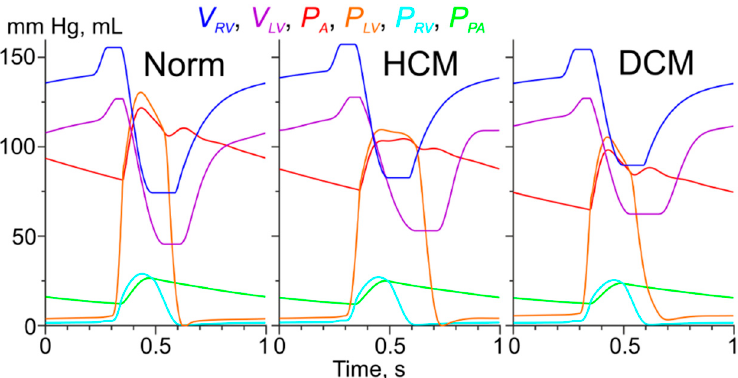
Figure 2. The results of the simulations of heartbeats for model of the normal (Norm) left ventricle (LV) cardiac muscle and those with the Ile284Val (hypertrophic cardiomyopathy, HCM) and Asp230Asn (dilated cardiomyopathy, DCM) Tpm mutations. V RV , V LV are volumes of the right and left ventricles, respectively; P A , P LV , P RV , and P PA are pressures in aorta, left and right ventricles and pulmonary artery, respectively. The color code is shown on top of the plots.